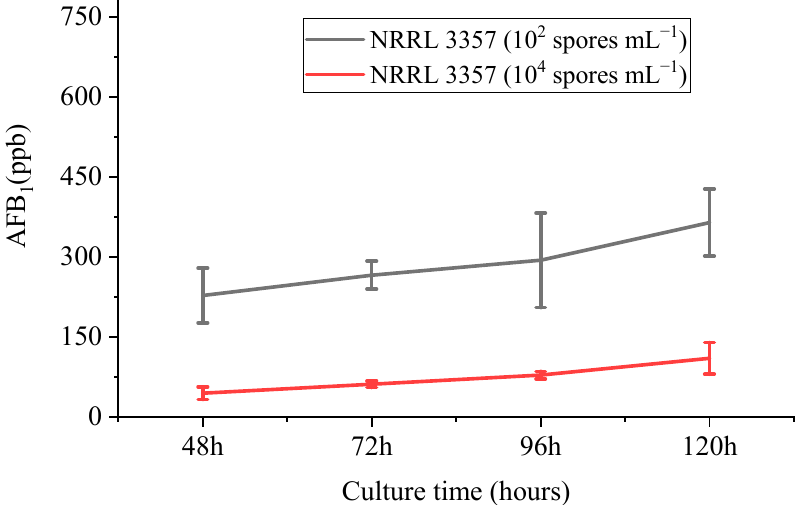
Figure 3. AFB 1 concentrations in the maize-agar medium with two treatments. There was a significant treatment effect ( p < 0.05), and a statistically significant interaction of treatment by day ( p < 0.05).